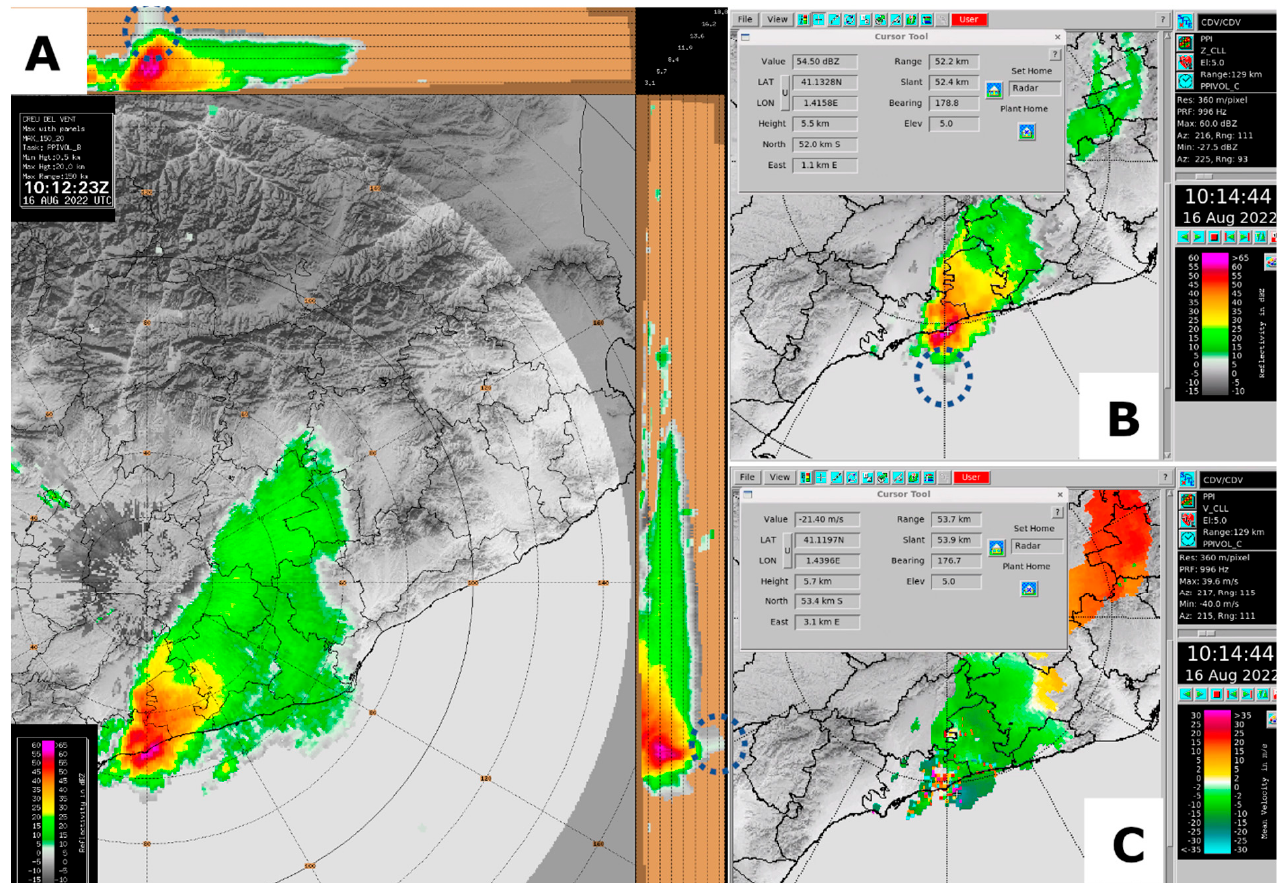
Figure 2. ( A ) Evolution of the MAX reflectivity product at 1012 UTC on 16 August 2022. ( B ) PPI of reflectivity at 5° elevation for the same times as ( A ). ( C ) The same as ( B ), but for the Doppler velocity field. The circles with a dashed blue line in ( A , B ) indicate the location of the TBSS.